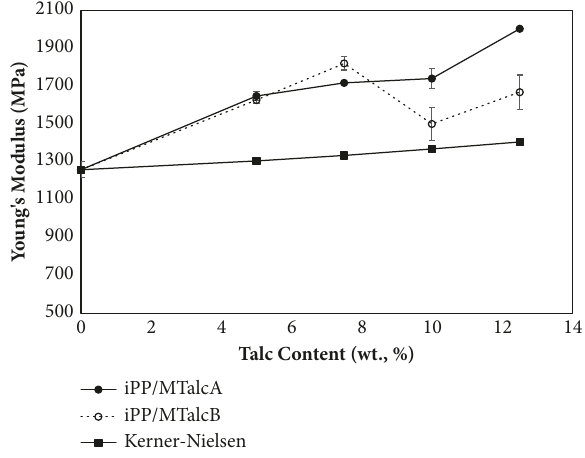
Figure4:Young’smodulus versus fillercontentcurvesofcomposites based on iPP/MTalc A and iPP/MTalc B, experimental data and predicted values determined by Kerner-Nielsen